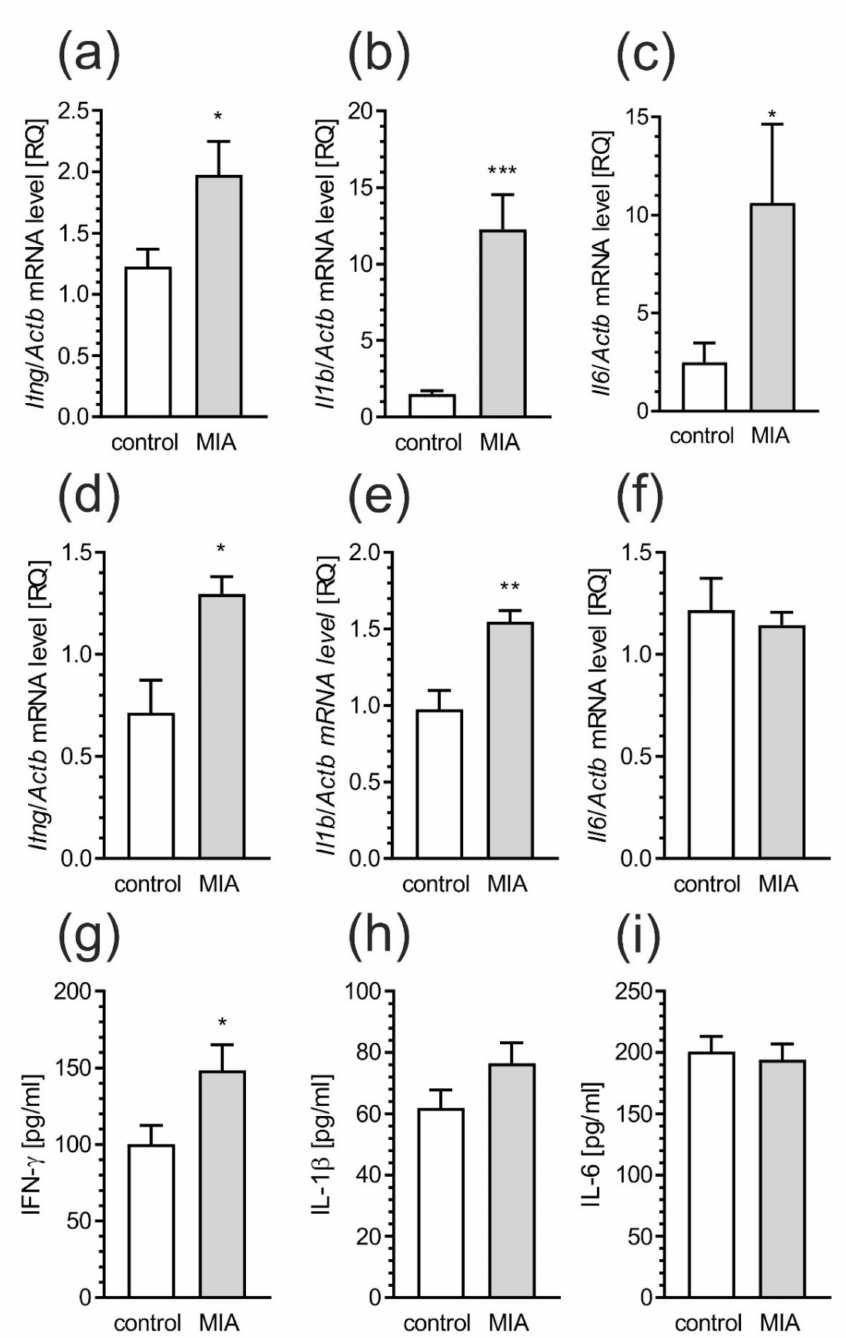
Figure 13. MIA induces neuro-inflammatory responses in fetuses and in the brain of o ff spring rat pups. Rat fetuses, 24 h after induction of MIA, and o ff spring male rats at PND 7, were sacrificed and whole tissues, or brain tissues were collected, respectively. ( a – c ) The expression of pro-inflammatory genes in fetuses 24 h after induction of MIA was measured by real-time PCR and normalized to Actb ( β -actin), as a reference gene. ( d – f ) The expression of pro-inflammatory genes in brain of o ff spring male rats at PND 7 was measured by real-time PCR and normalized to Actb ( β -actin), as a reference gene. ( g – i ) The level on pro-inflammatory cytokines in brain of o ff spring male rats at PND 7 was determined by using the immunoassay. Data represent the mean value ± S.E.M. (a–n = 8 and 7, b–n = 8, c–n = 7 and 8, d–n = 5 and 4, e–n = 4 and 5, f–n = 5, g–n = 5, h–n = 6 and 5, i–n = 6). * p < 0.05, ** p < 0.01, *** p < 0.001, compared to control group using Student’s t